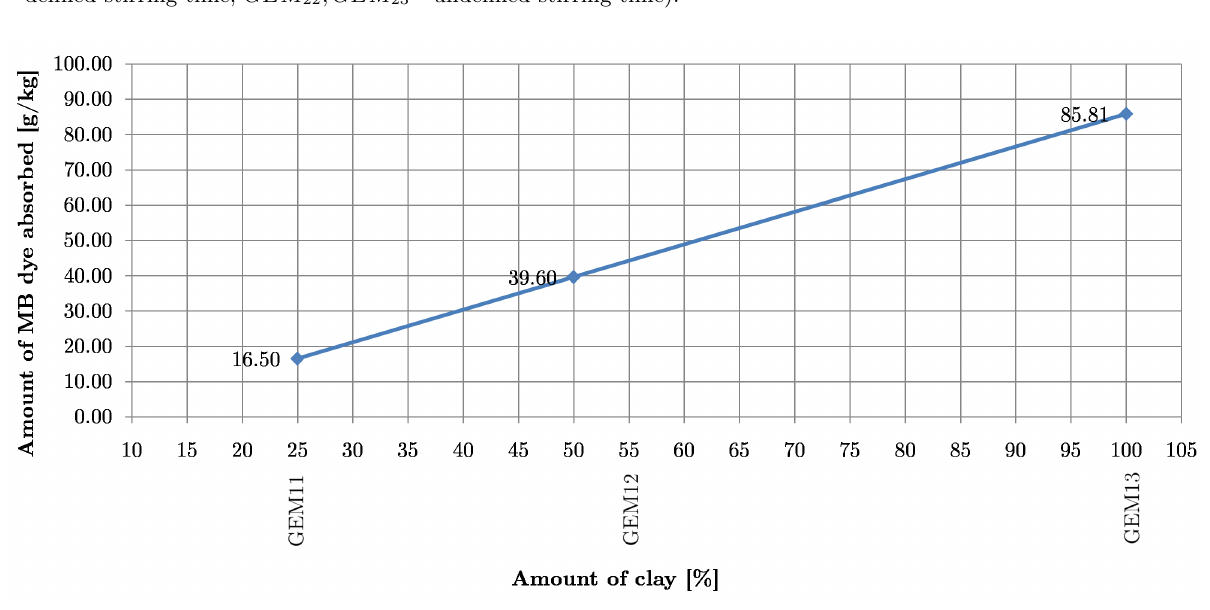
Table 8. Difference between amount of MB dye absorbed with and without defined stirring time ( GEM defined stirring time; GEM 22 , GEM 23 - undefined stirring time).